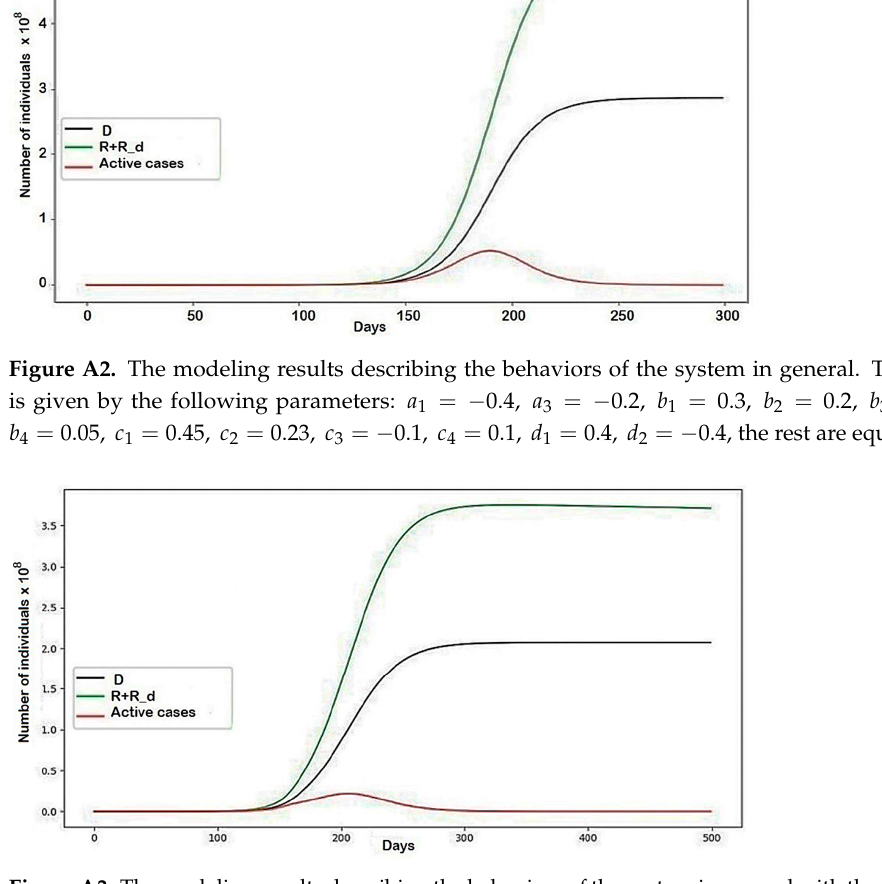
Figure A3. The modeling results describing the behaviors of the system in general with the param- eters represented in Table 1.